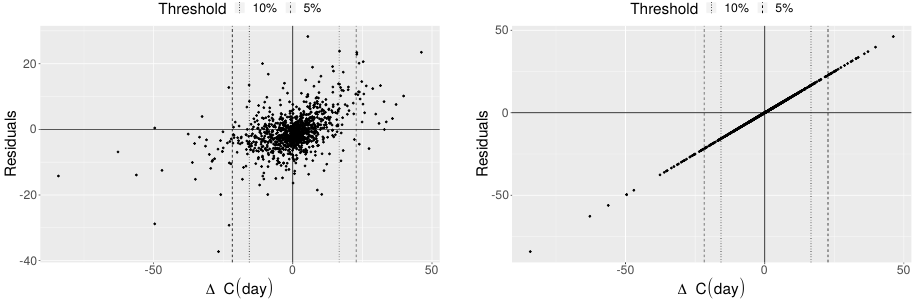
Figure 3. Residuals of the random forest model ( left ) and the persistence model ( right ) for PM 10 levels forecasted for Ljubljana against ∆ C(1 day) actual levels. The persistence model (on the right) is not good as it does not predict any change so the residuals are equal to the observed